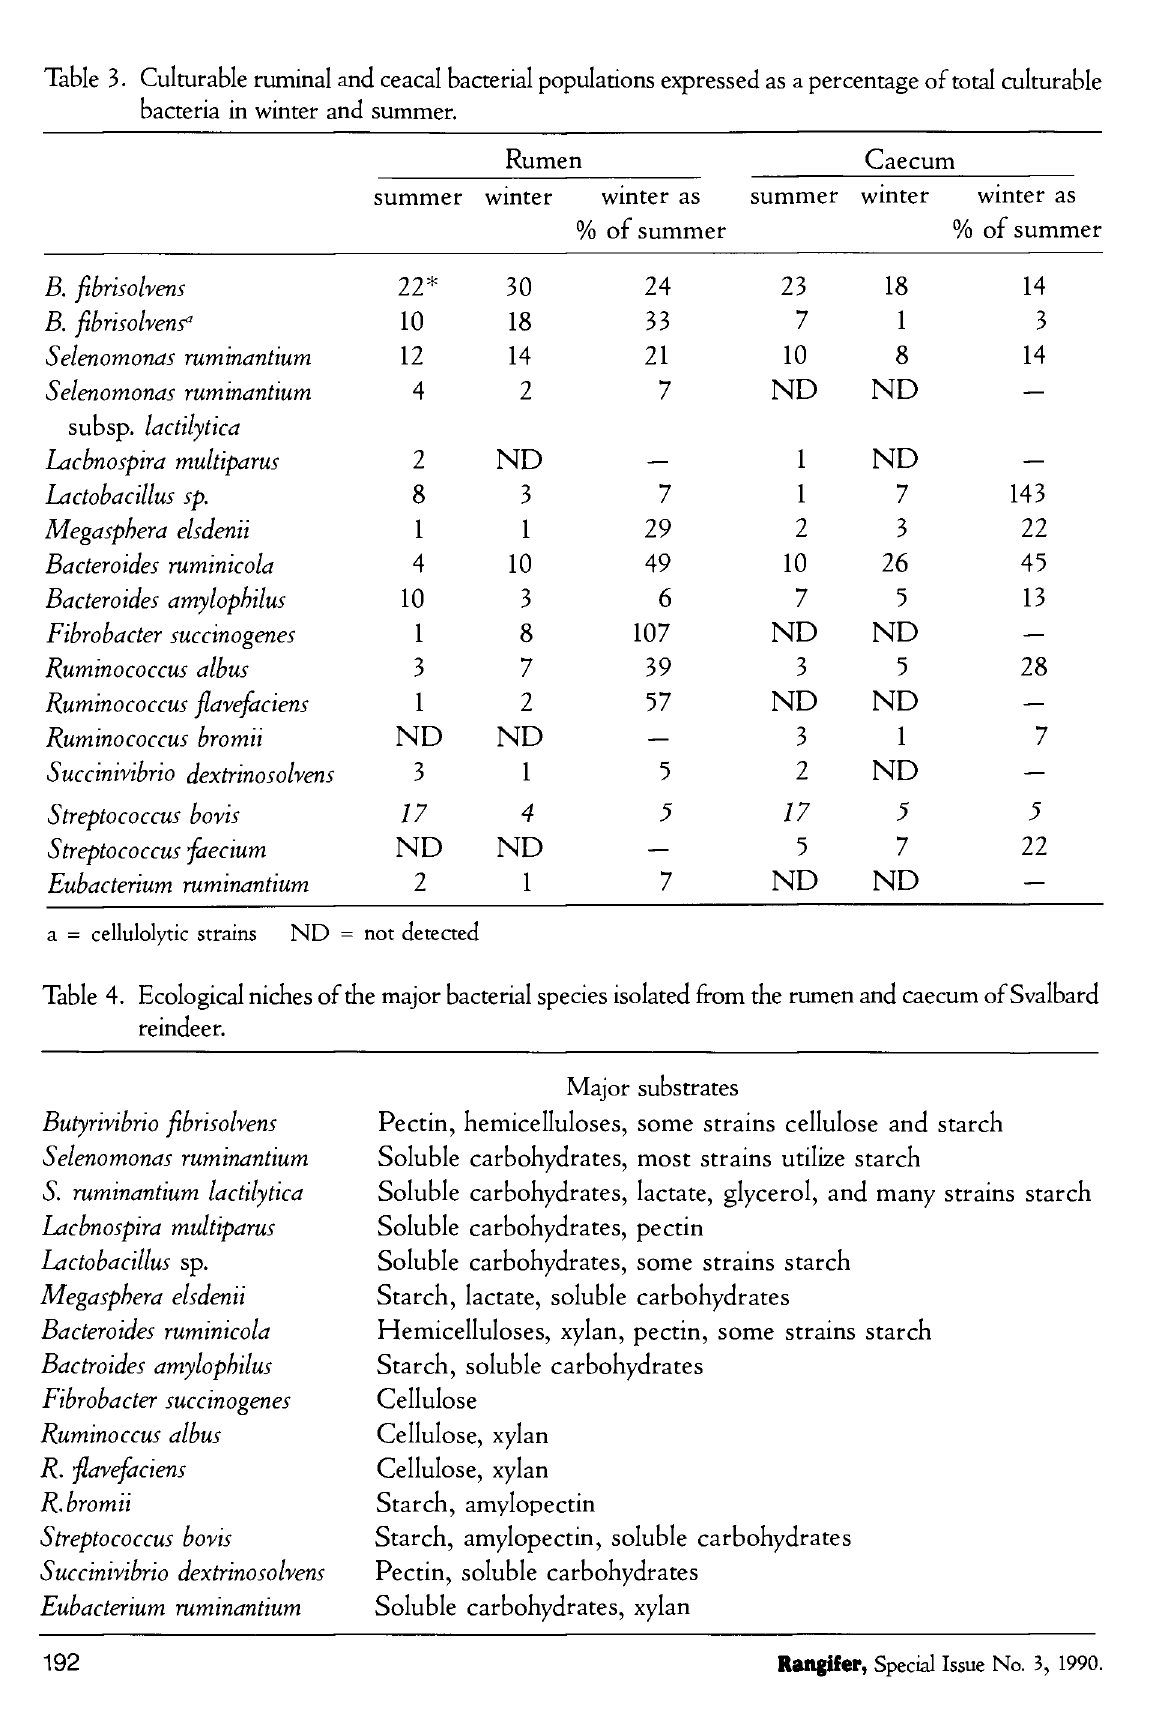
Table 3. Culturable ruminal and ceacal bacterial populations expressed as a percentage of total culturable bacteria in winter and summer.